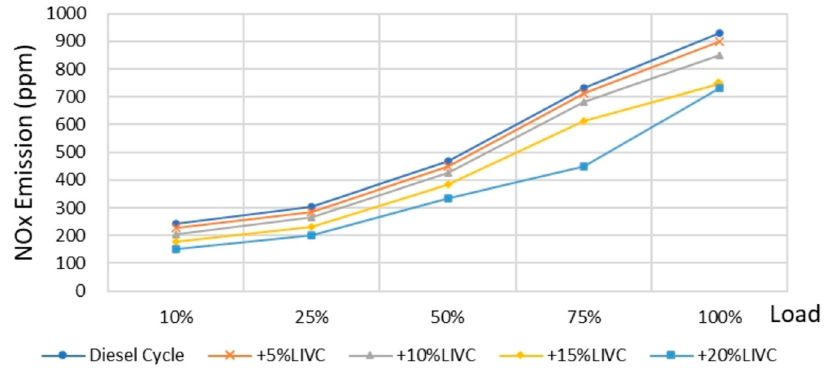
Figure 9. Comparison of BSFC under diesel engine LIVC Miller cycle.